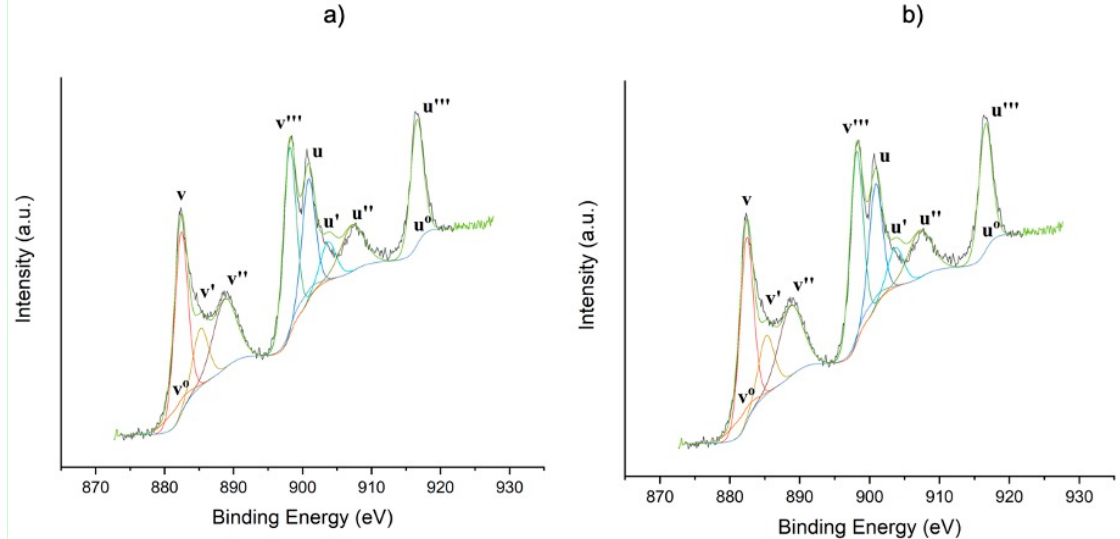
Figure 3. Ce 3d XPS spectra of ( a ) Ce 0.75 Zr 0.25 O 2 support and ( b ) 5%Ag/Ce 0.75 Zr 0.25 O 2 catalyst.